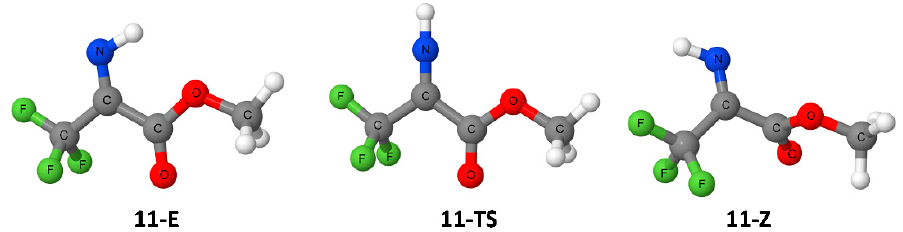
Organics 2021 , 2 , FOR PEER REVIEW Figure 14. Optimized structures of the Z- and E-isomers of compound 11 ( 11-Z and 11-E , respectively),